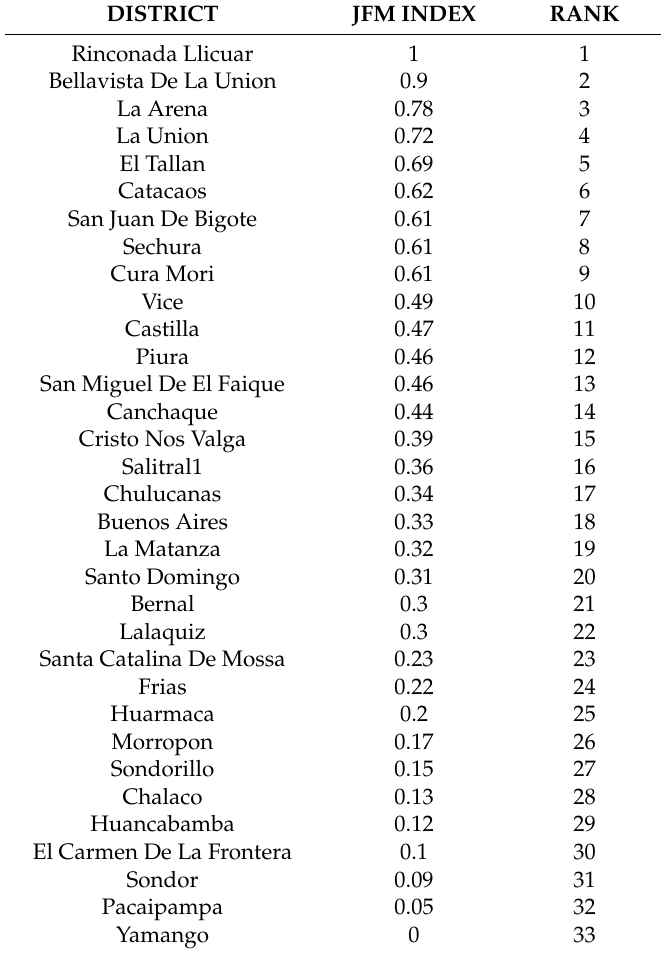
Table A5. Ecosyndemic index and rank by district for the season (JFM) in 1998.